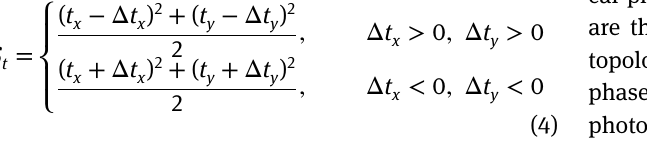
. The dash line x , y